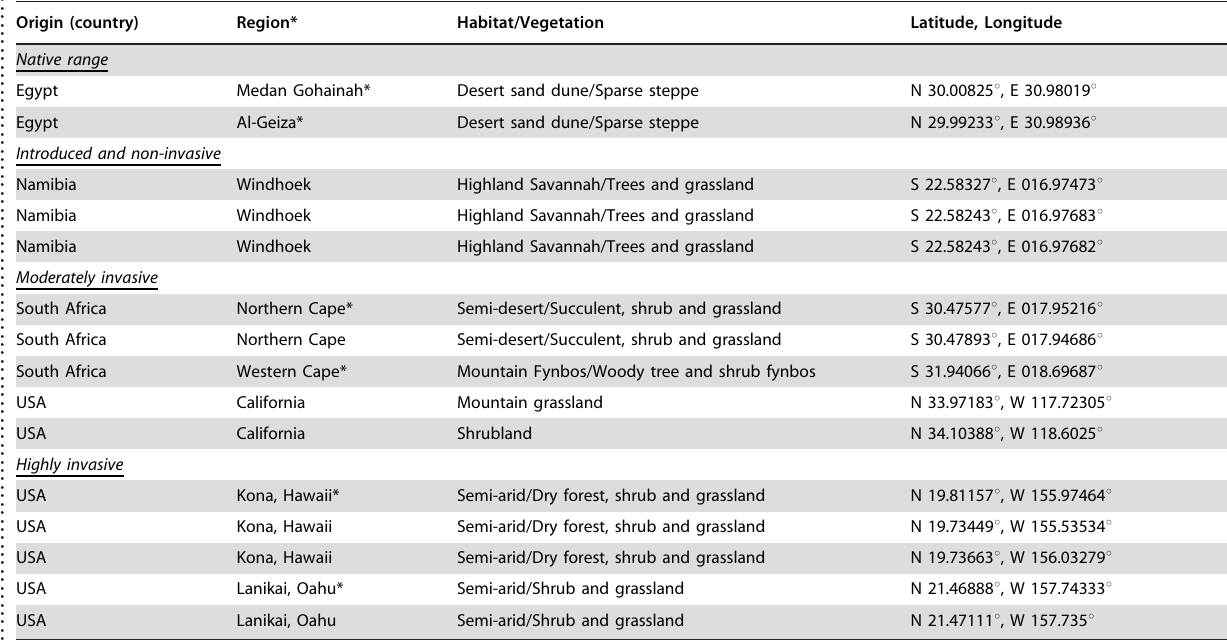
Table 2. Globally invasive and native populations of Pennisetum setaceum used in this study. .. ... .... ... ... .... ... ... .... ... ... .... ... ... .... ... ... .... ... ... .... ... ... .... ... ... .... ... ... .... ... ... .... ... ... .... ... ... .... ... ... .... ... ... . Origin